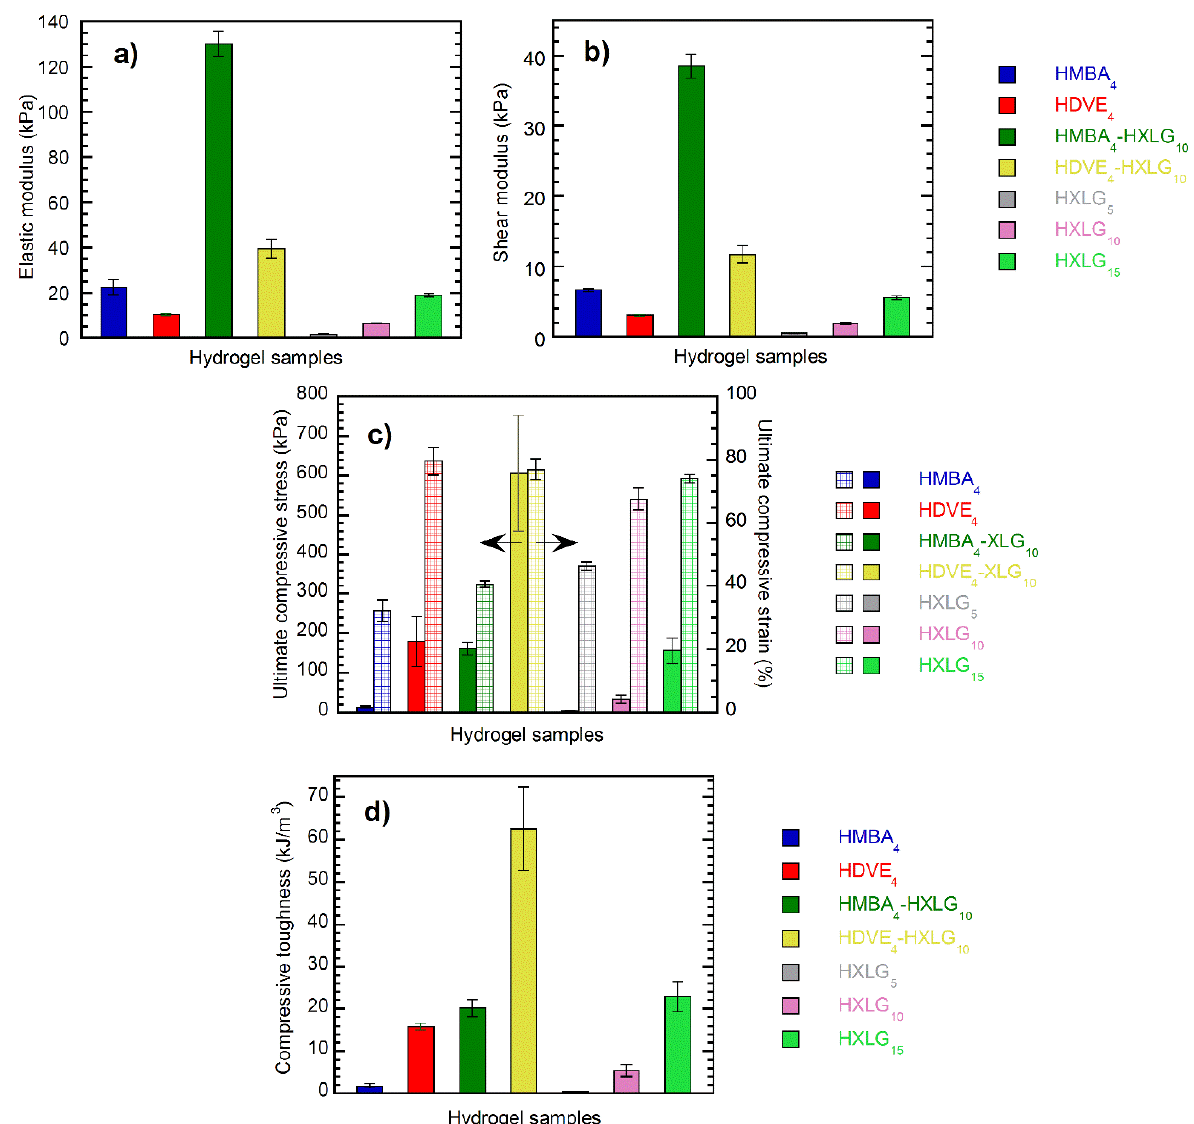
XLG and 156.03 ± 32.65 kPa for 15 wt% XLG.